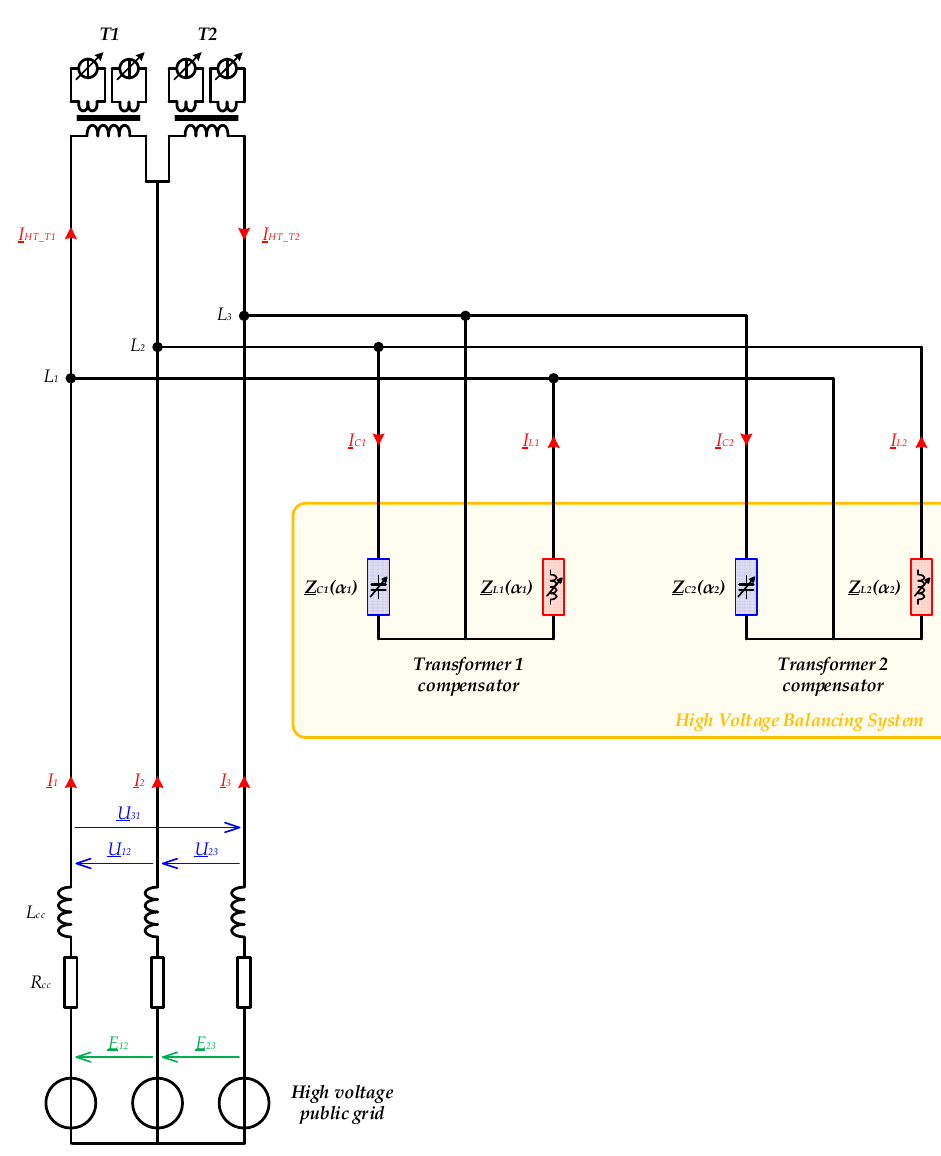
Figure 10. Equivalent circuit of the substation with the HVBS connected.